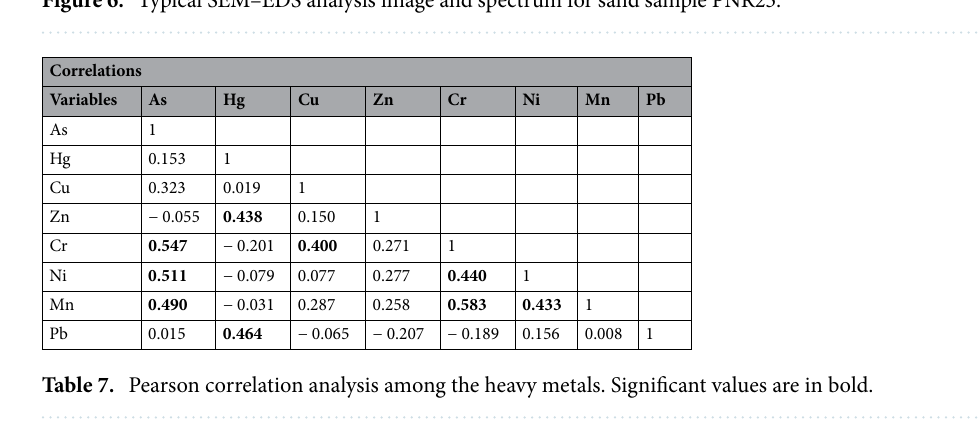
Figure 6. Typical SEM–EDS analysis image and spectrum for sand sample PNR25.